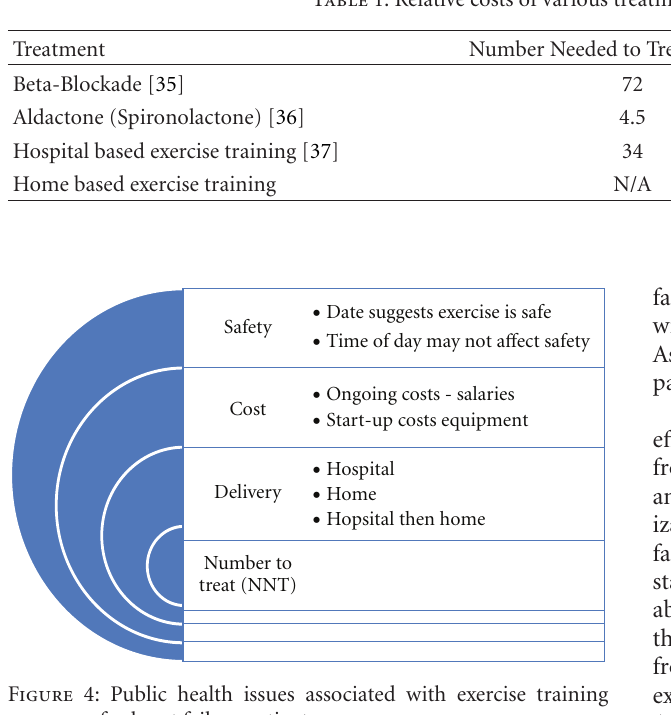
Table 1: Relative costs of various treatments for one mortality avoided.